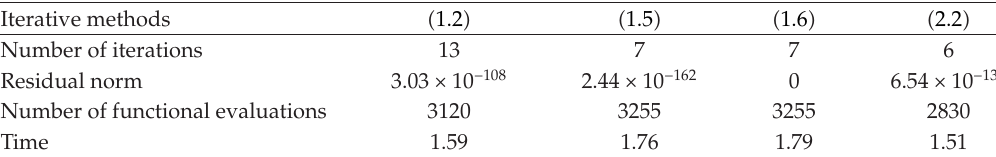
Table 2: Results of comparisons for di ff erent methods in Example